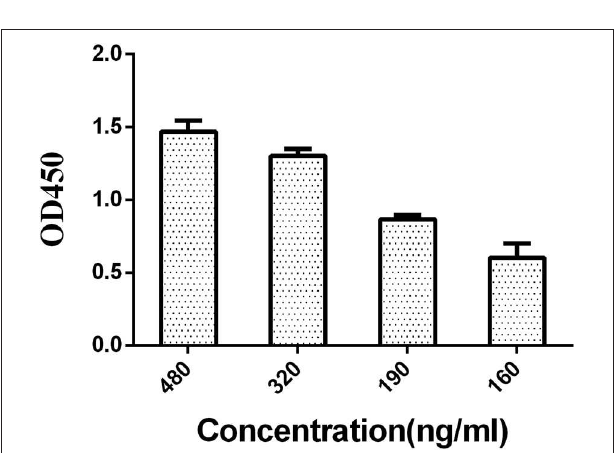
FIGURE 3 | Concentration optimization of coated LPS in O 9 Dc-ELISA.